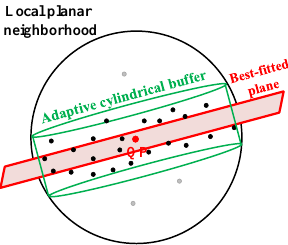
Figure 2. Adaptive cylindrical buffer of a query point (QP) belonging to a planar